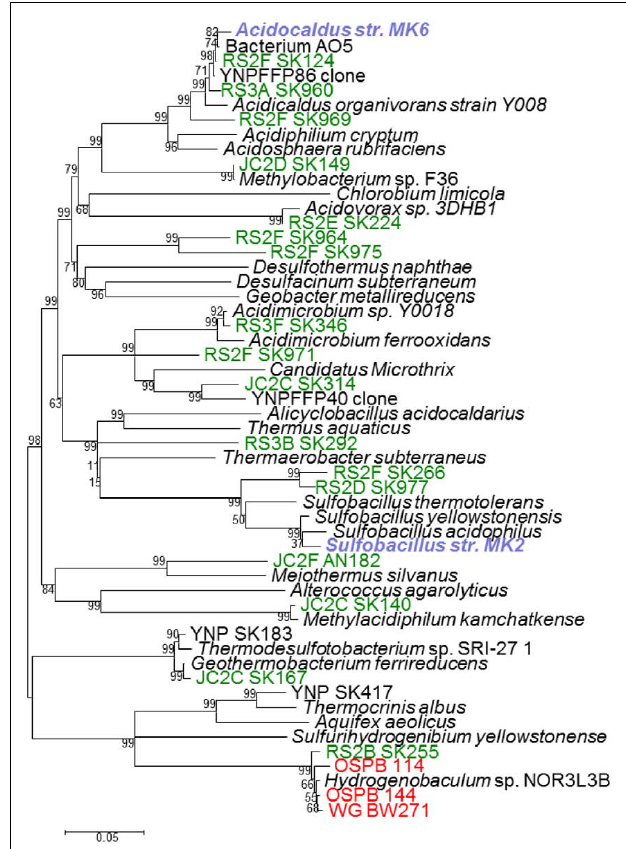
FIGURE 7 | Phylogenetic tree of bacterial 16S rRNA gene sequences ( ∼ 1400bp) observed across 19 different acidic iron mats in Yellowstone National Park (acid-sulfate-chloride springs are shown in red, acid-sulfate springs shown in green, isolates are highlighted in blue, and metagenome sequence entries are listed in dark